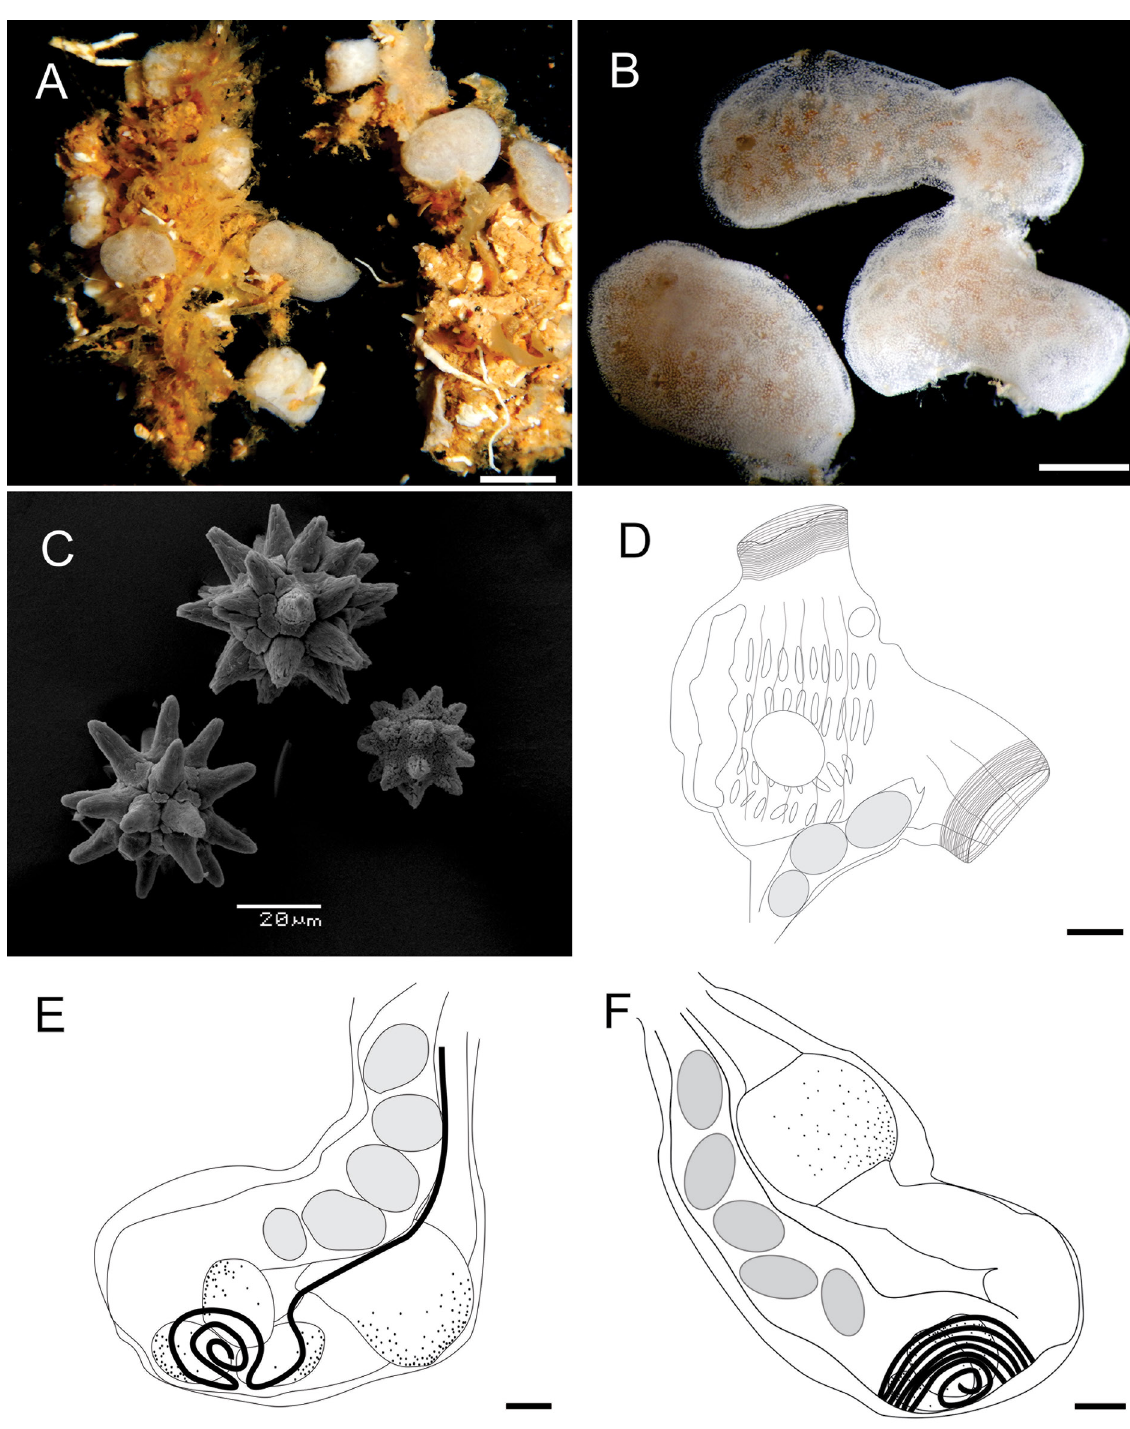
Fig. 5. Leptoclinides sp. (DZUP LEP-009). A . Preserved colony on algae. B . Detail of preserved colonies. C . Spicules. D . Thorax. E–F . Abdomen. Scale bars: A = 1 cm; B = 0.5 cm; D–F = 0.1